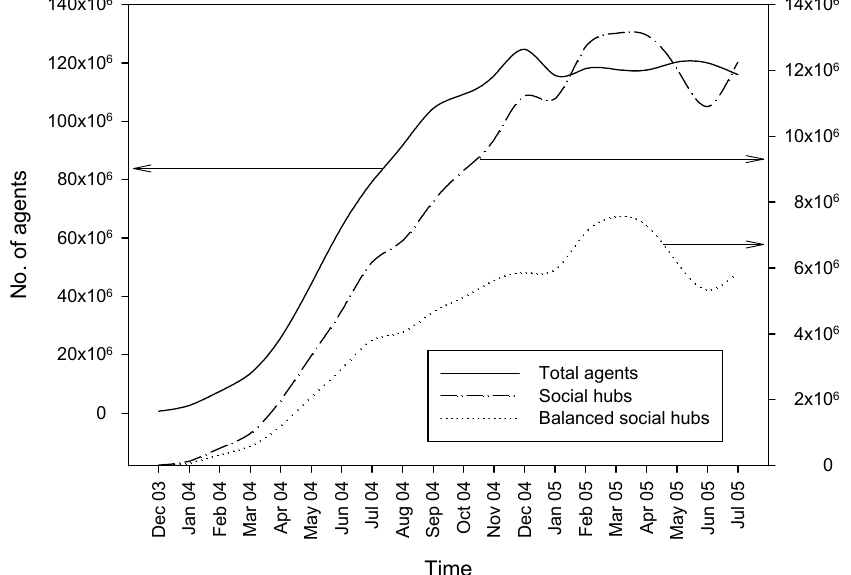
<Figure 3.1> The number of total agents vs. social hubs and balanced social hubs over